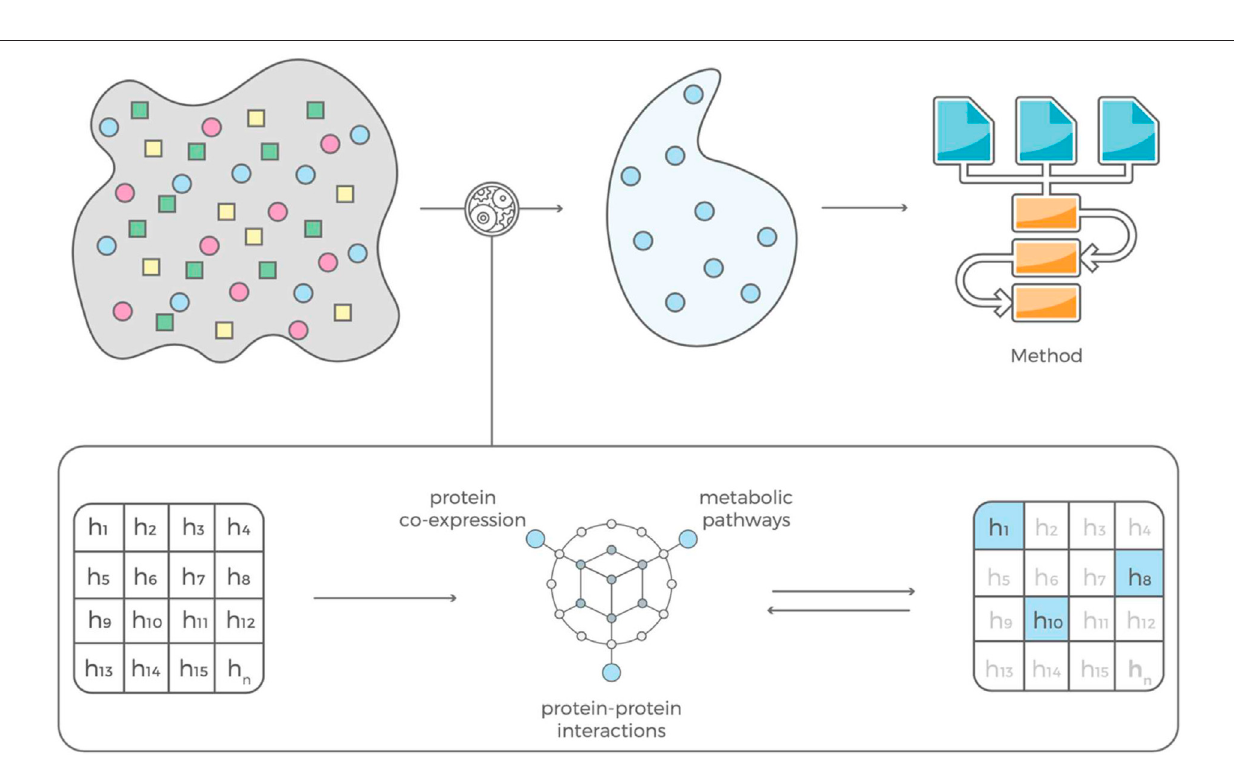
coding region of GAPDHP25 , glyceraldehyde-3 phosphate